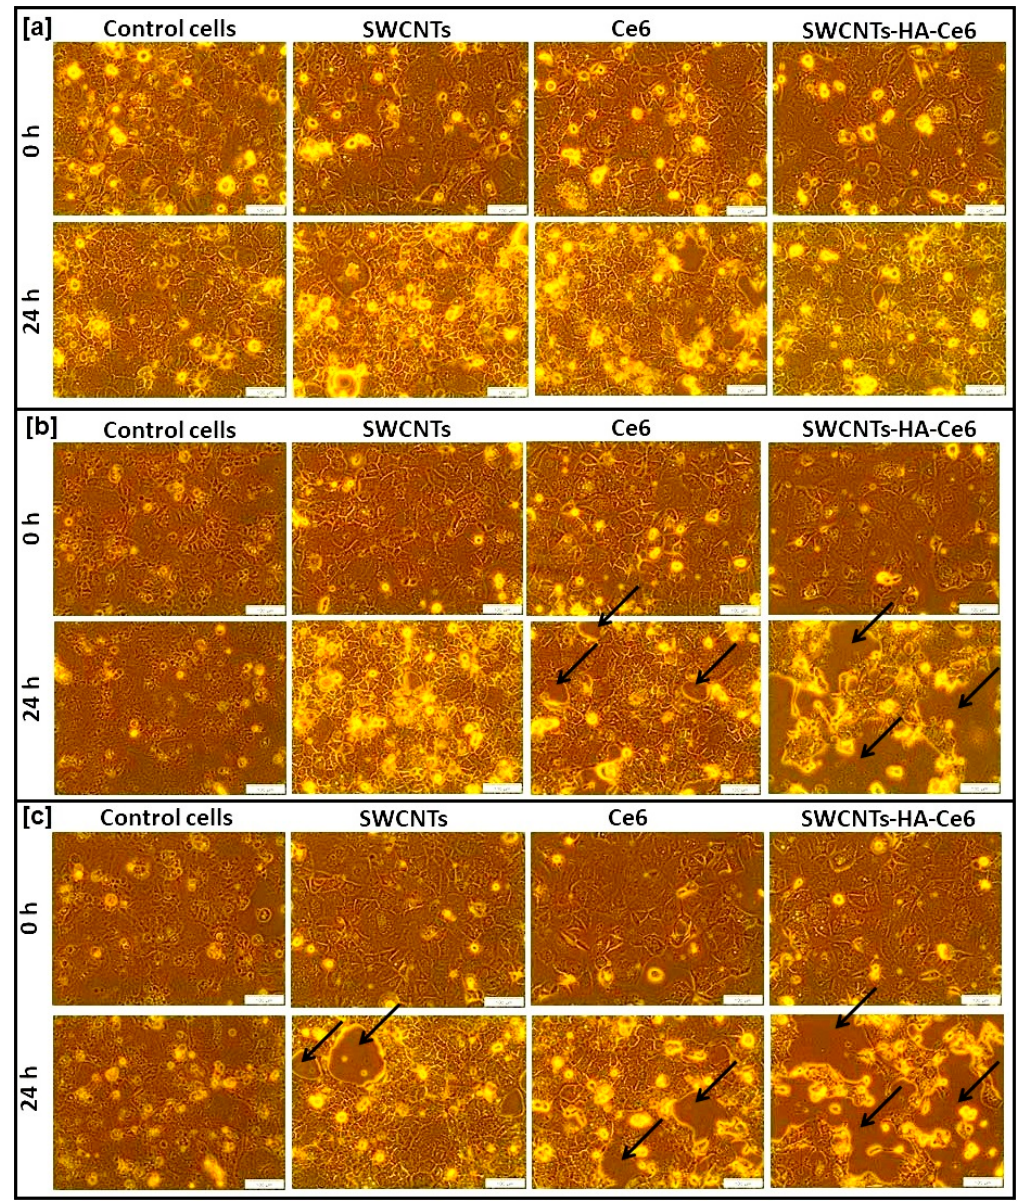
Figure 5. Microscopic images of untreated and treated cells. ( a ) group 1 cells (untreated) of 0 h and 24 h, ( b ) group 2 cells (5 J / cm 2 ) of 0 h and 24 h ( c ) group 3 (10 J / cm 2 ) cells of 0 h and 24 h. Scale bar represents 100 μ m. Black arrow indicates the cellular death.